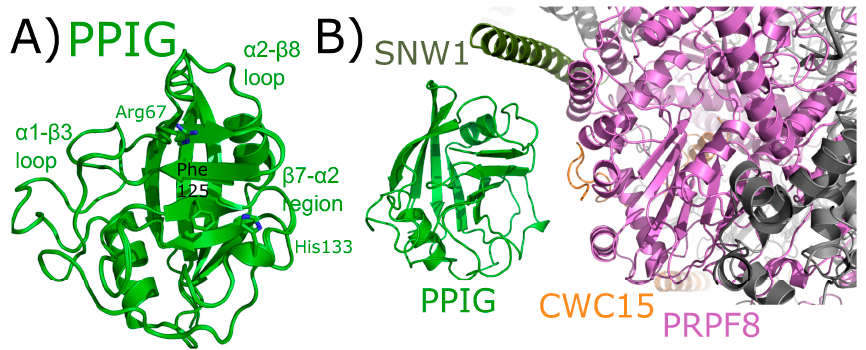
Figure 11. PPIG structures in and out of the spliceosomal context. In ( A ), the isomerase domain of PPIG is shown in cartoon representation (overlay of PDB IDs: 2GW2, 2WFI, and 2WFJ). Selected residues in the catalytic site, along with regions of protein–protein interactions, are labeled. In ( B ), the neighborhood around the isomerase domain of PPIG in the catalytic C spliceosome (PDB ID: 5YZG). Potential interactions between PPIG and SNW1, CWC15, and PRPF8 are highlighted. No model exists for the roughly 600 residues outside of the PPIG isomerase domain.